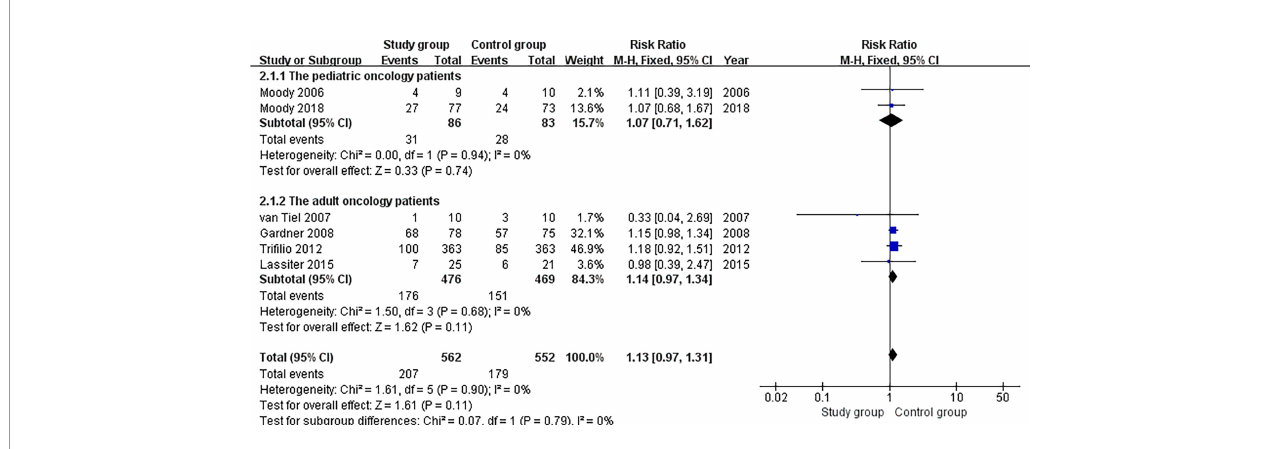
FIGURE 5 | Subgroup analysis for pediatric and adult oncology